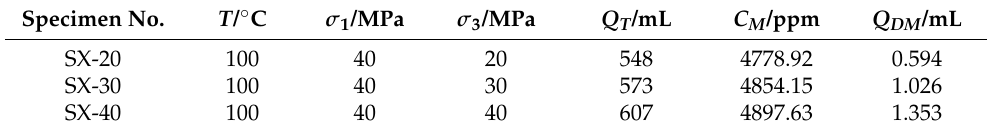
Table 1. Total production volume of gas and methane collected in the test. Specimen